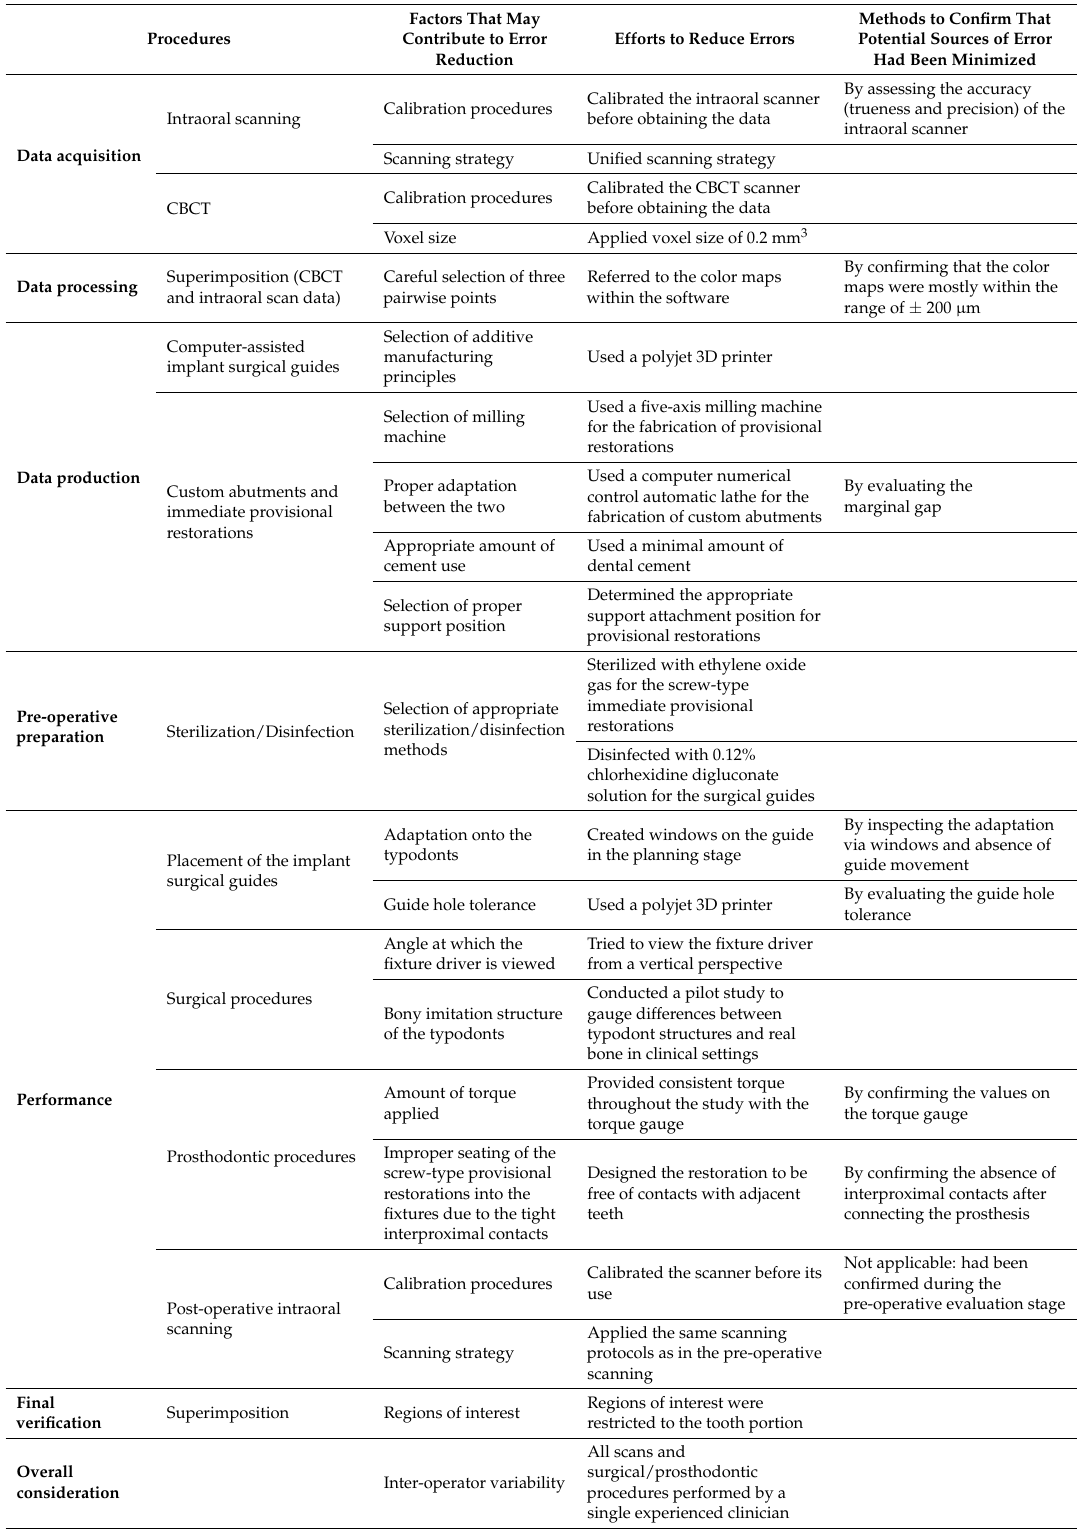
Table 2. Potential sources of error and the efforts to minimize them. CBCT, cone-beam computed